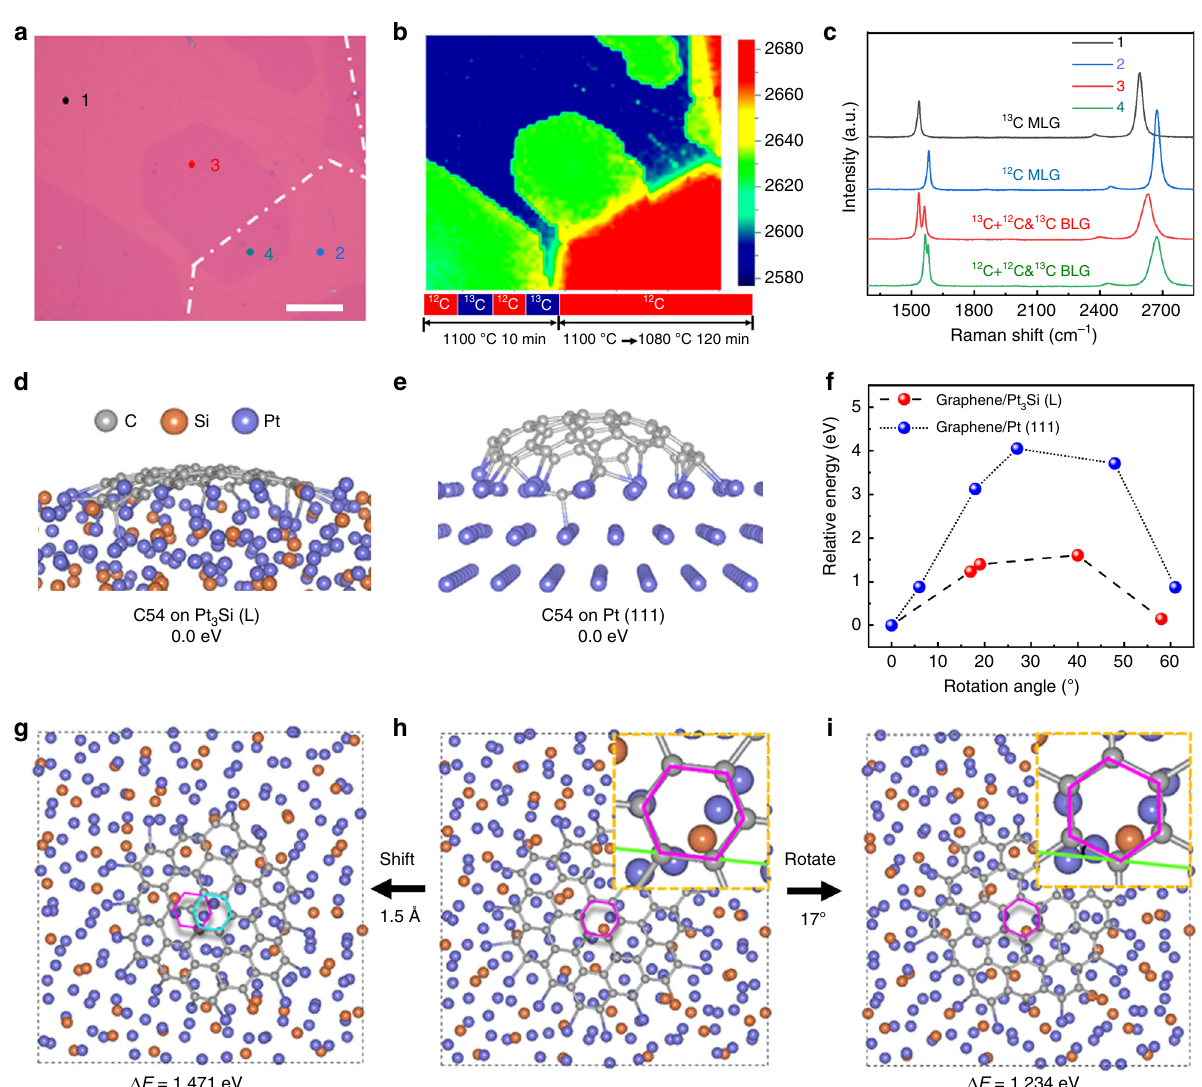
Fig. 4 Interlayer epitaxial growth mechanism of AB-BLG fi lms on liquid Pt 3 Si/solid Pt substrate. a , b Optical image ( a ) and the corresponding isotopically labeled Raman map of 2D peak position ( b ) of an AB-BLG transferred on SiO 2 /Si substrate. The dashed lines in ( a ) indicate the boundary of 12 C and 13 C isotopic rings in the fi rst layer. c Raman spectra of isotopically labeled monolayer and bilayer graphene regions indicated in ( a ). d , e The side view diagrams of the atomic structures of graphene nucleus (C54) on liquid Pt 3 Si surface ( d ) and solid Pt (111) surface ( e ) at 1500 K. f The relative energies of graphene nucleus (C54) on solid Pt (111) and liquid Pt 3 Si surfaces as a function of rotation angle at 1500 K. g – i The diagrams of three representative atomic structures of graphene nucleus (C54) on liquid Pt 3 Si surface. The atomic structure in ( h ) can be converted into the atomic structures in ( g ) and ( i ) by a translation of 1.5 Å and 17° rotation, respectively. The corresponding energy requirements for each movement were shown below. Scale bar: a 50 μ